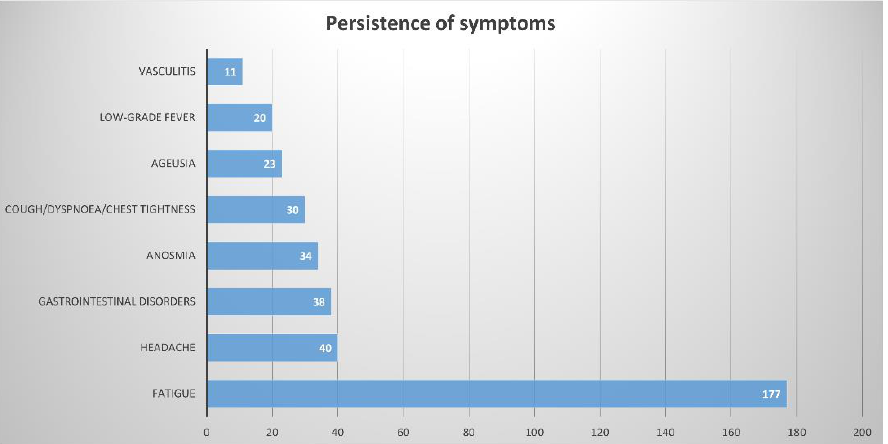
Figure 1. Absolute numbers of answers relating to persistence of symptoms.